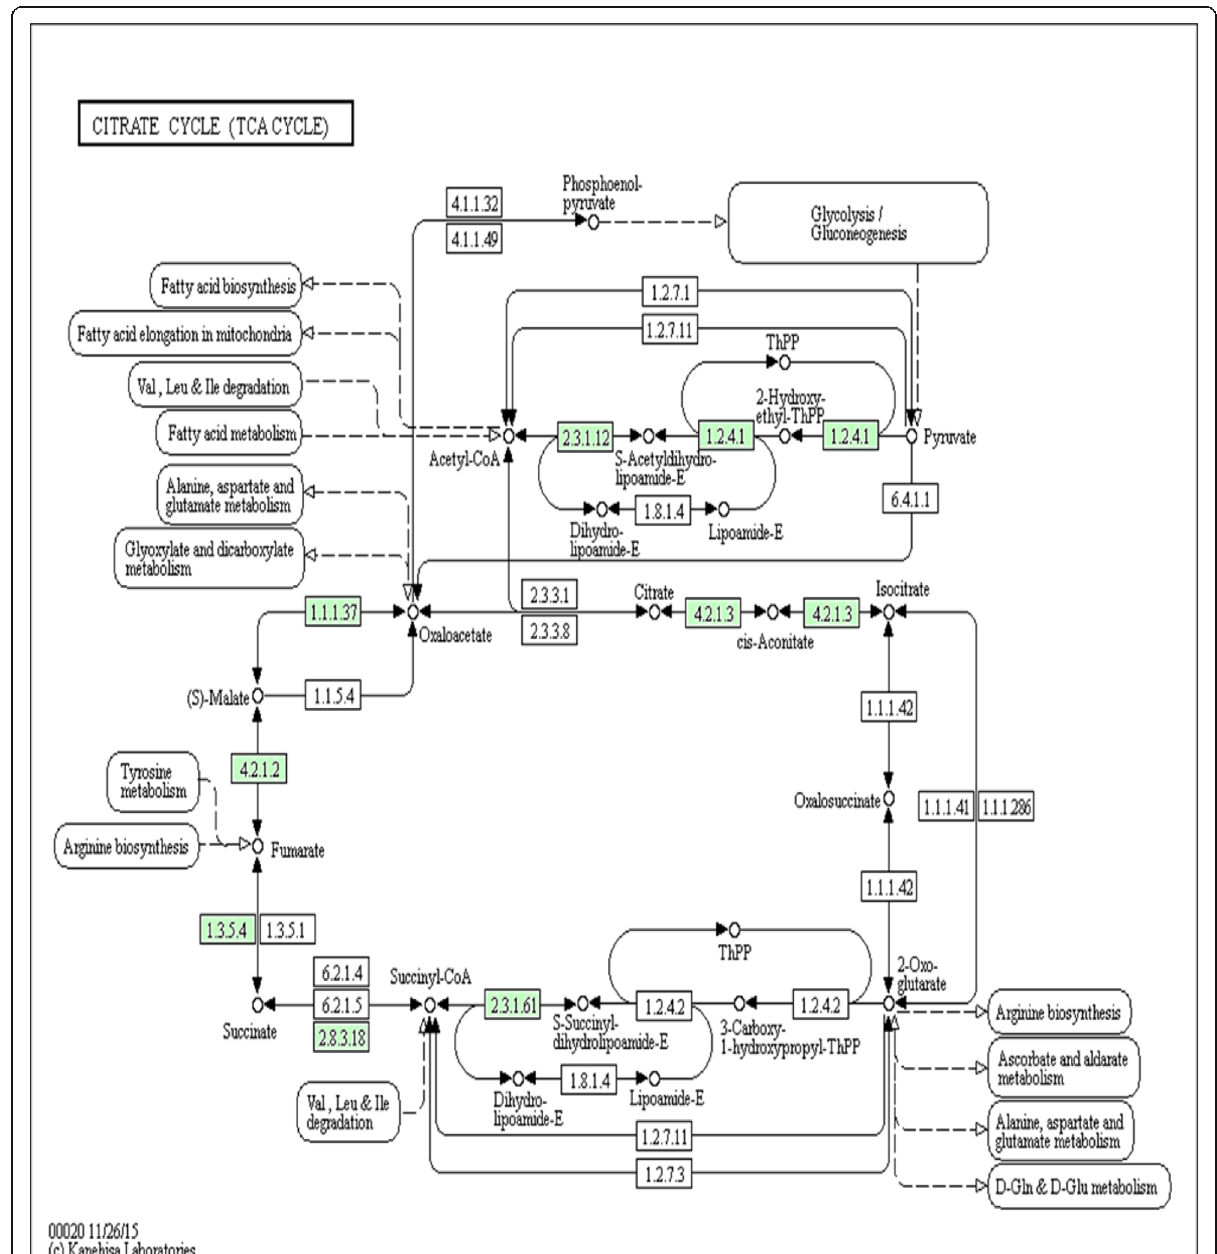
Fig. 2 Pathway of citric acid (TCA) cycle performed using the KEGG pathway in KEGG Orthology. EC numbers in green are the enzymes identified in AB1